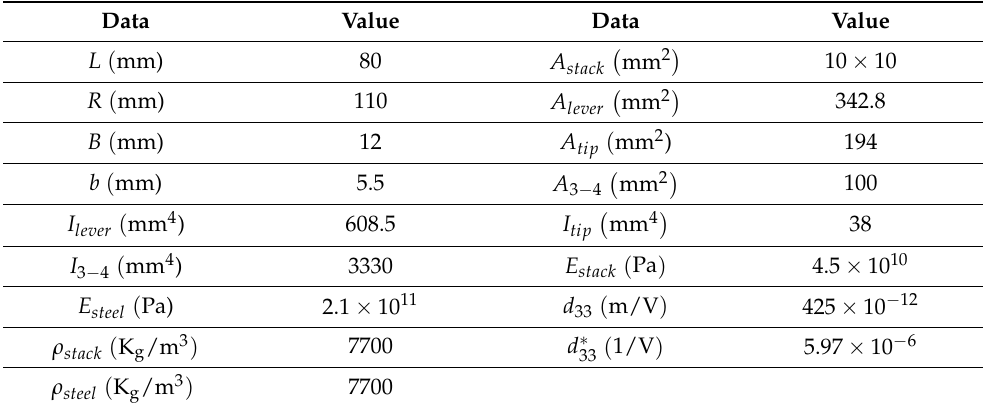
Table 2. Actuator FEM model data.